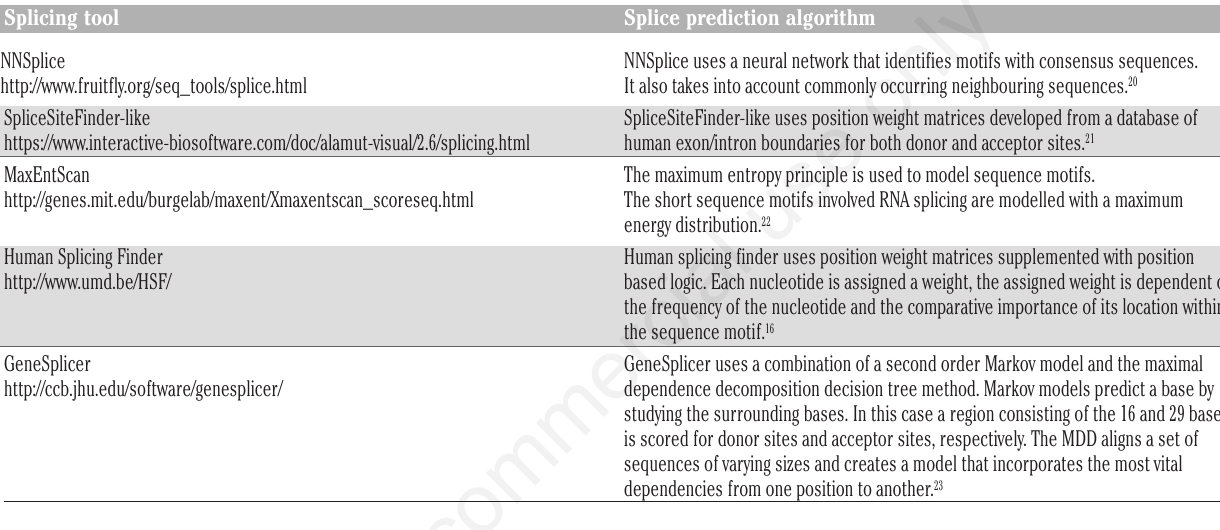
Table 1. Algorithm by which the various tools predict splicing effects. Splicing tool Splice prediction algorithm